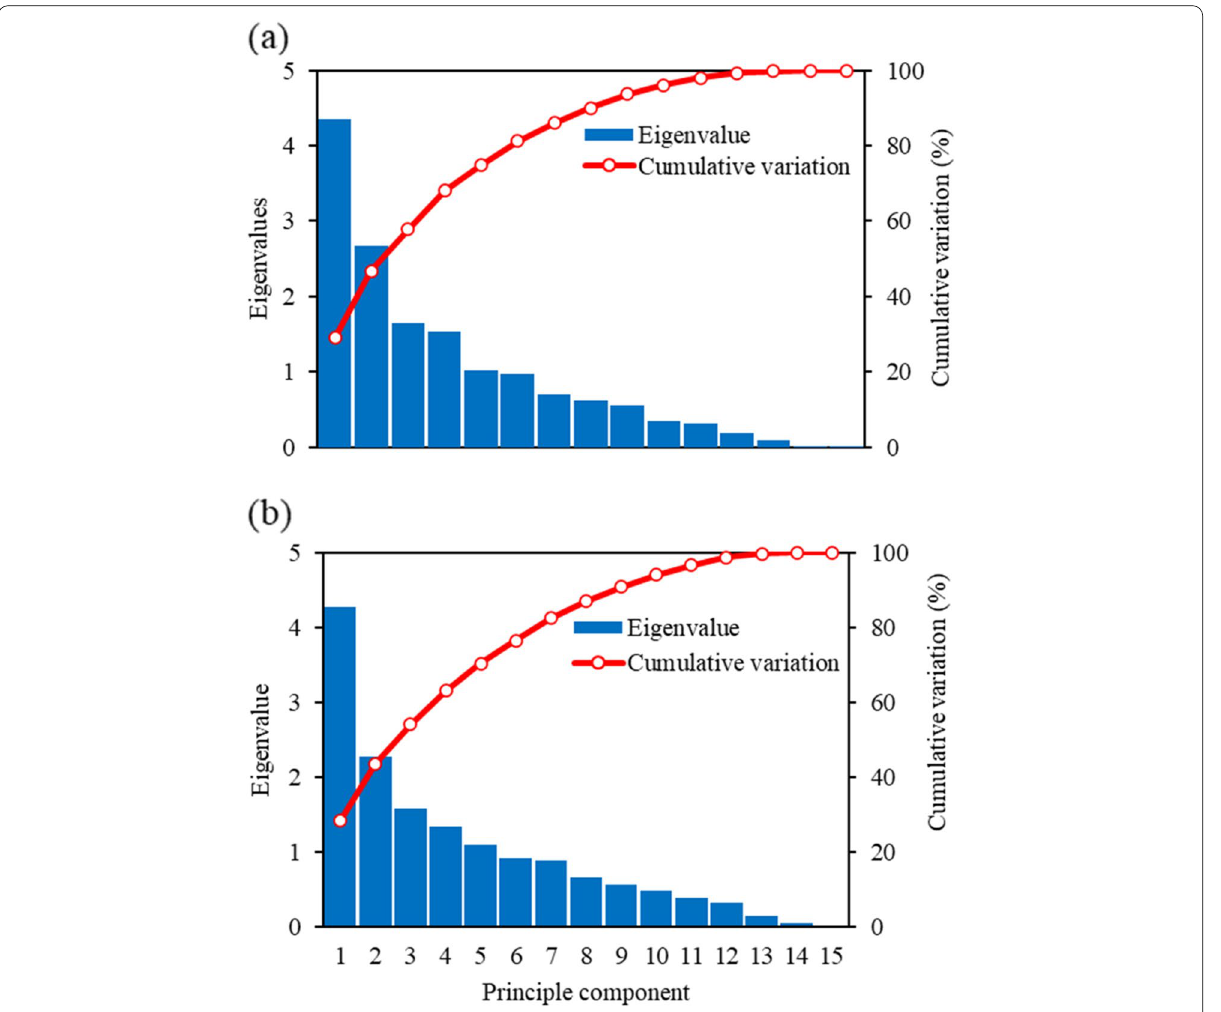
Fig. 6 Screening chart of principal components in ( a ) dry season and ( b ) rainy